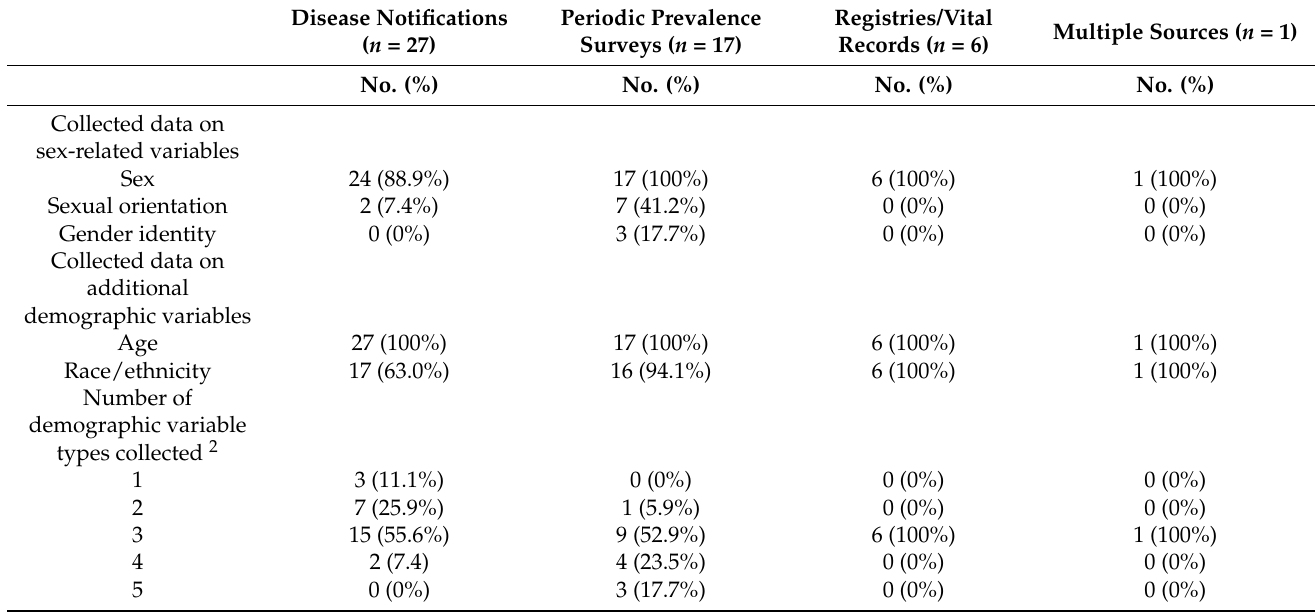
Table 3. Number and percentage of U.S. public health data and monitoring systems collecting sex-related variables, age, and race/ethnicity by type of data system, 2015–2018 1